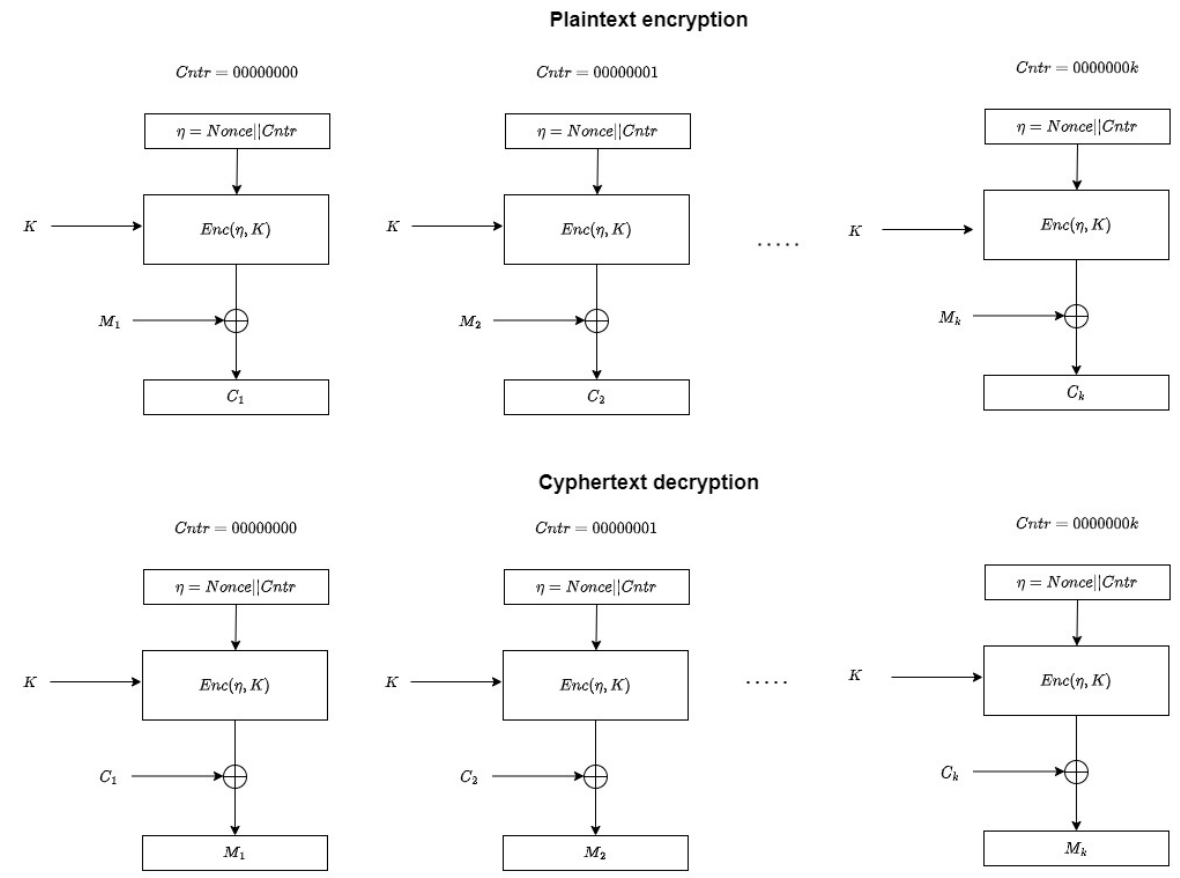
Figure 1. Encryption and decryption procedures of CTR